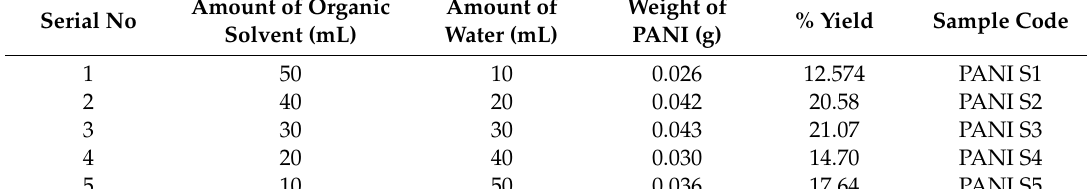
Table 5. Effect of amount of solvents (diesel/water) on percent yield of PANI. Table 5. E ff ect of amount of solvents (diesel / water) on percent yield of PANI.